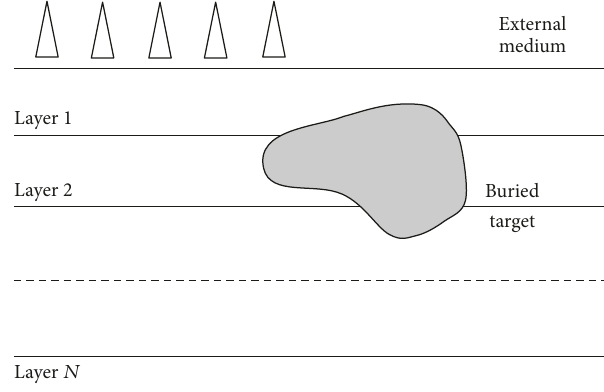
Figure 3: Schematic representation of an imaging system for buried object detection in a stratified